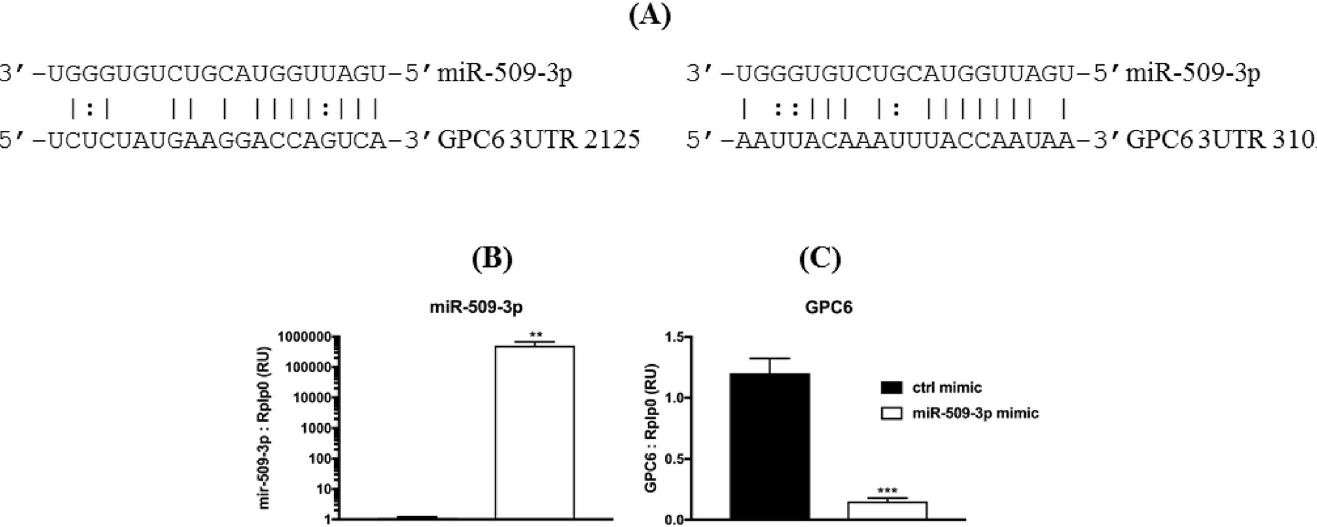
Fig 3. GPC6 is a putative target of miR-509-3p and overexpression of miR-509-3p downregulates GPC6 mRNA levels. (A) Predicted binding sites of miR-509-3p on the 3’-UTR of human GPC6 gene (NM005708). (B-C) A375 cells were transfected with 4nM negative control mimic (mimic ctrl) or miR-509-3p mimic for 48 hours. RNA was collected and RNA levels of miR-509-3p (B) and GPC6 (C) were measured using Taqman assays relative to Rplp0 from n = 3 experiments. Means ± S.D. �� , p < 0.001; ��� , p < 0.0001 for miR-509-3p mimic versus mimic control.